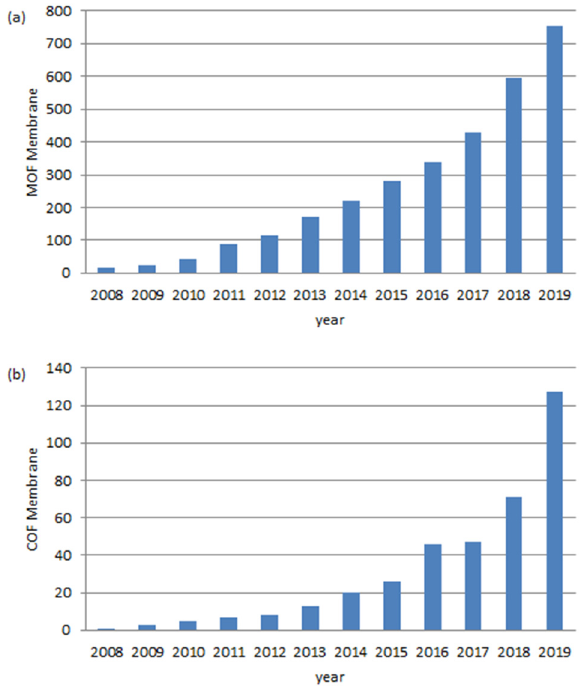
Figure 1. Number of publications per year ( a ) “Metal Organic Framework membranes” and ( b ) “Covalent Organic Framework membranes”. Data obtained from the Web of Science.